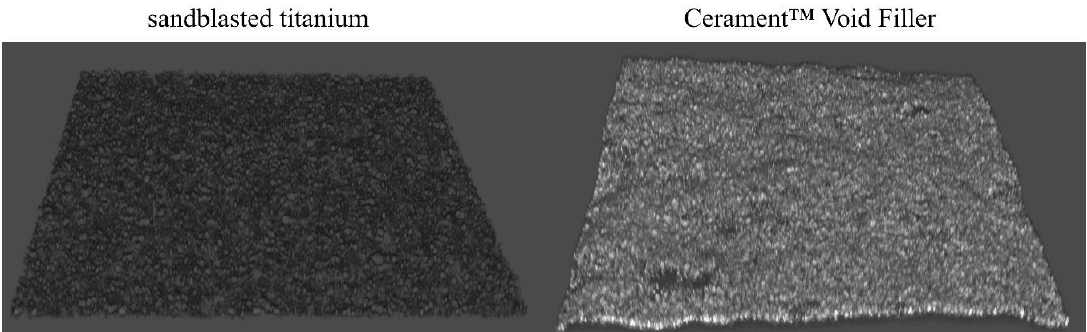
Figure 4. Representative CLSM 3D images of the surface characteristics of ST and CBVF. Magnification: 20x.